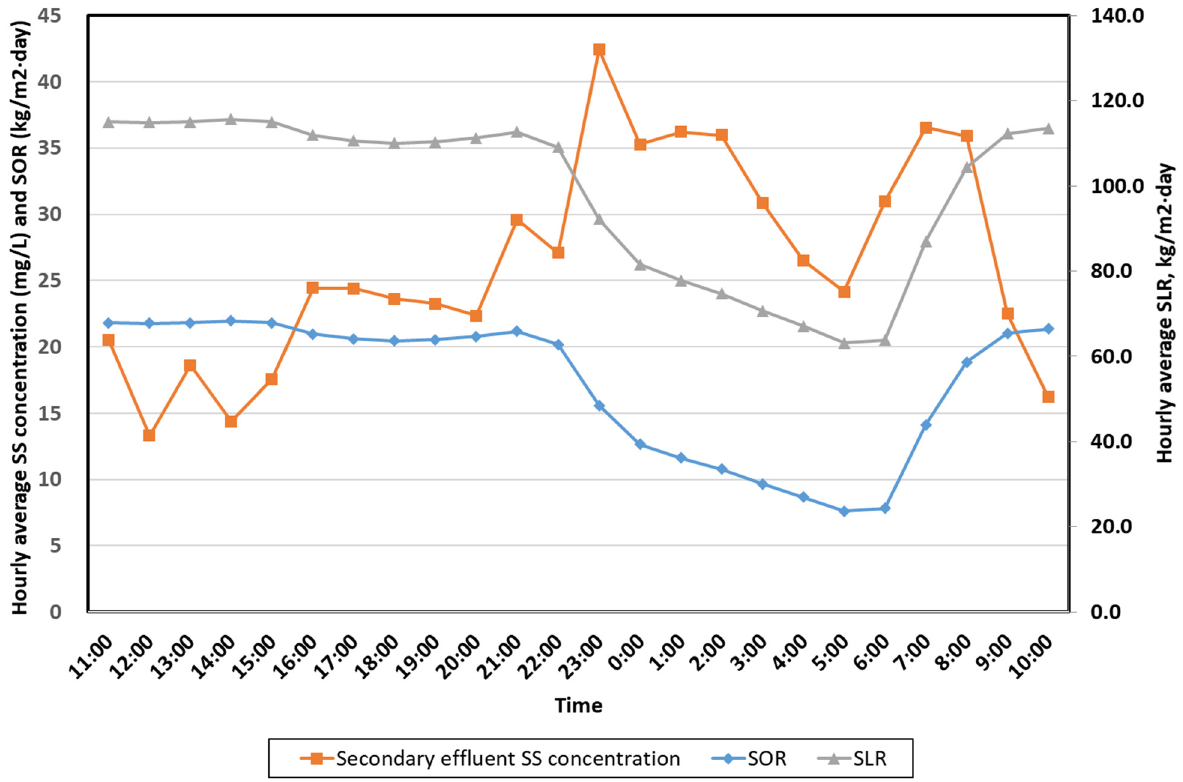
Figure 4. Average hourly effluent SS concentrations with average hourly SORs and SLRs at the secondary clarifier at plant A.